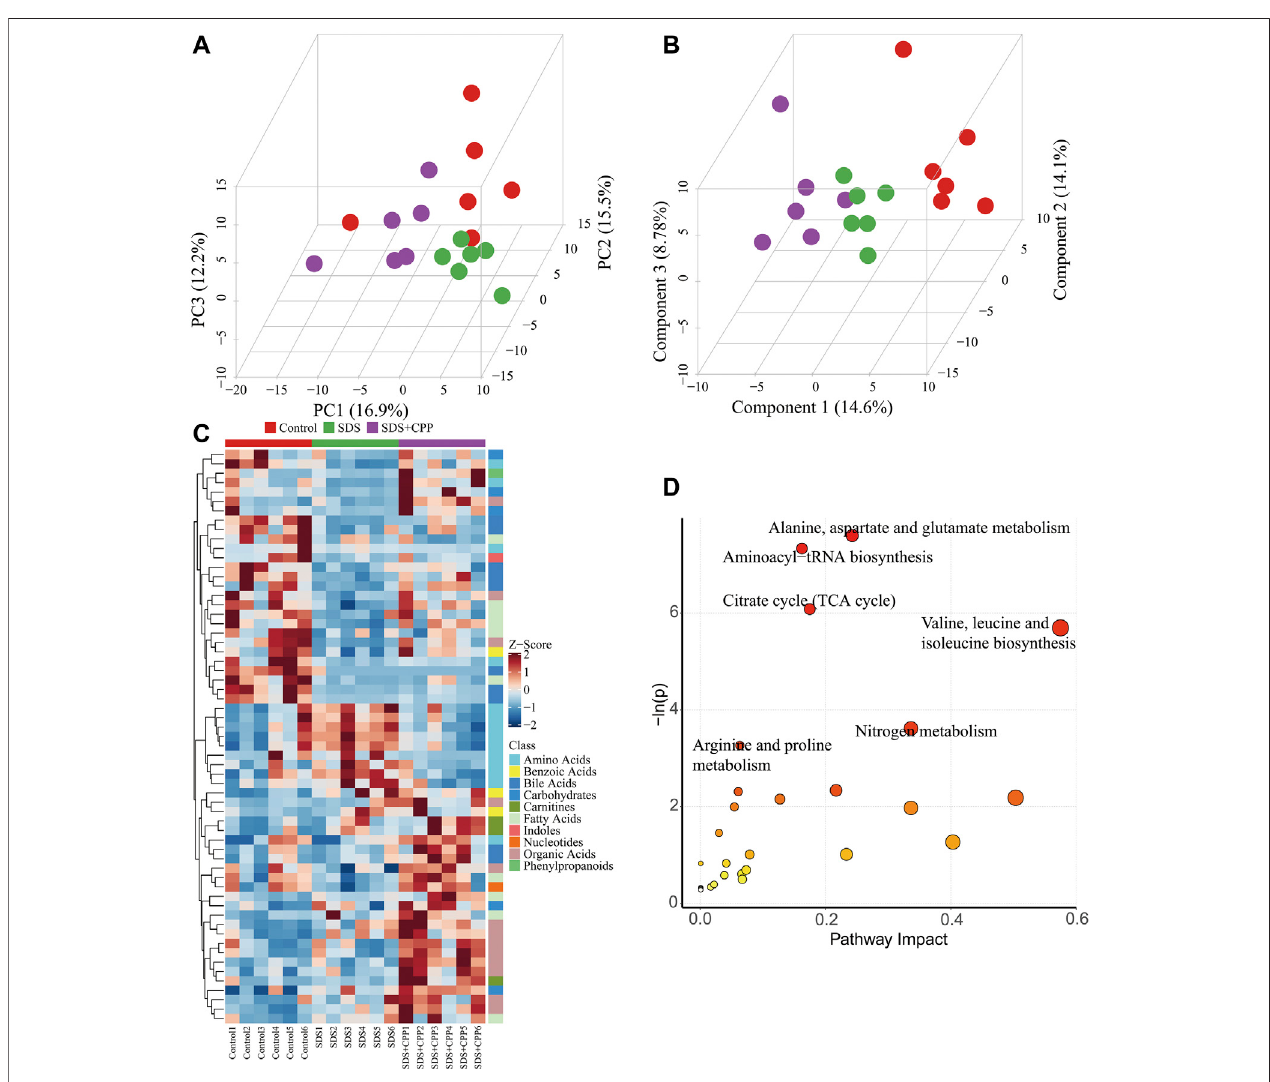
FIGURE 4 | Multivariate statistical analysis, heatmap visualization of differential metabolites, and summary of metabolome pathways. (A) 3D PCA score plot of the metabolite pro fi les of control, SDS and SDS + CPP groups. Each dot represents the colonic metabolite pro fi le of a single sample. (B) 3D PLS-DA score plot of different colonic content samples imply distancesamong groups. (C) Heatmap ofmetabolites distributions in thecolonic content foreach sample. Blocksin red and blue denote high and low Z-score values of metabolites, respectively. (D) Overview of pathway results (1) alanine, aspartate and glutamate metabolism, (2) aminoacyl-tRNA biosynthesis, (3) TCA cycle, (4) valine, leucine and isoleucine biosynthesis, (5) nitrogen metabolism, and (6) arginine and proline metabolism.